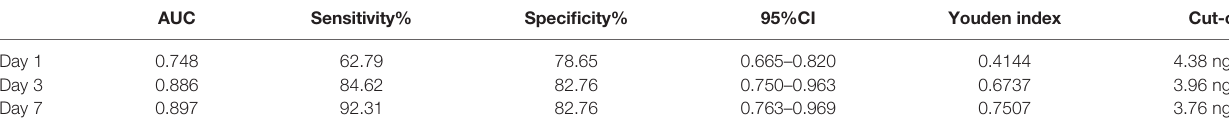
TABLE 5 | ROC curve analysis of dynamic monitoring GDF15 in the prognosis of sepsis. AUC Sensitivity% Speci fi city% 95%CI Youden index